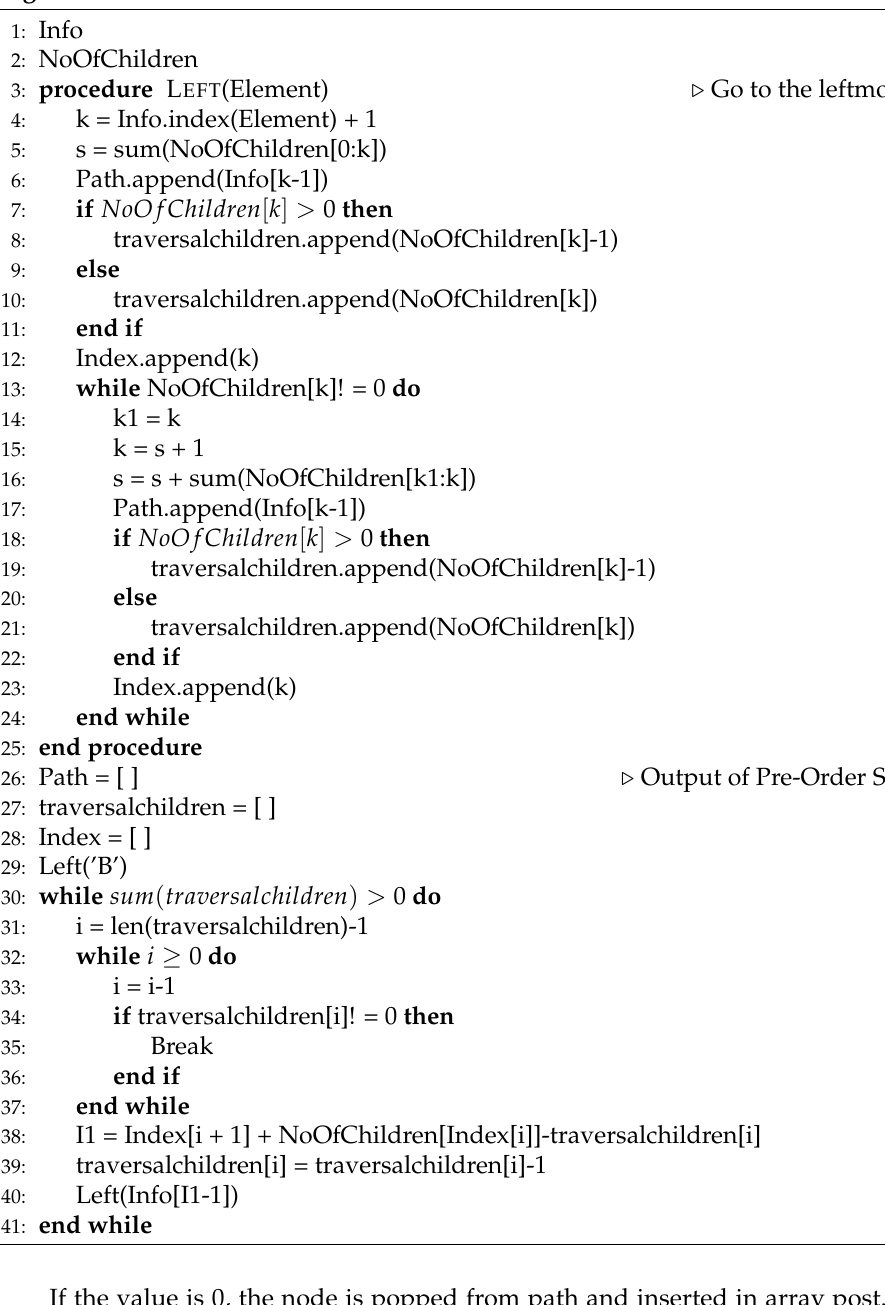
Algorithm 5 Pre-order